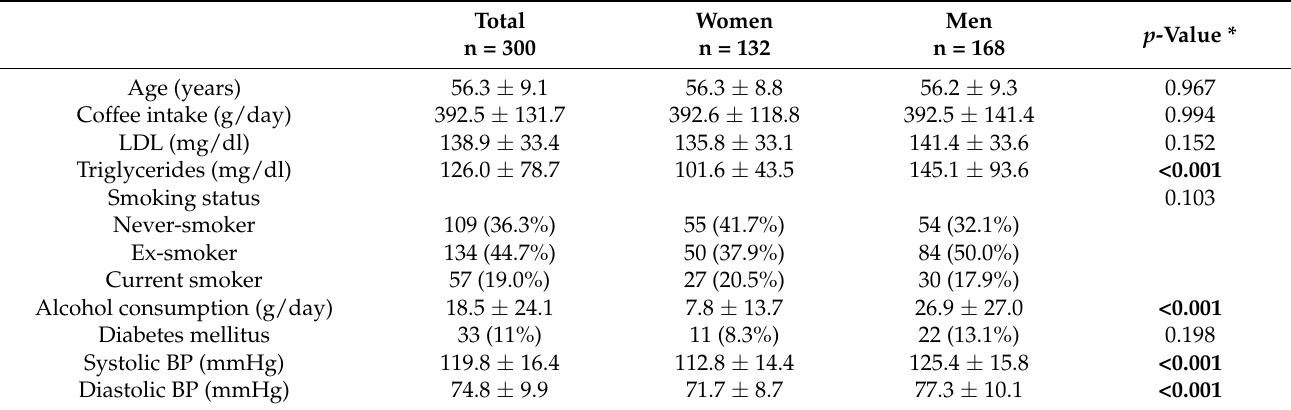
Table 1. Characteristics of the study population, stratified by